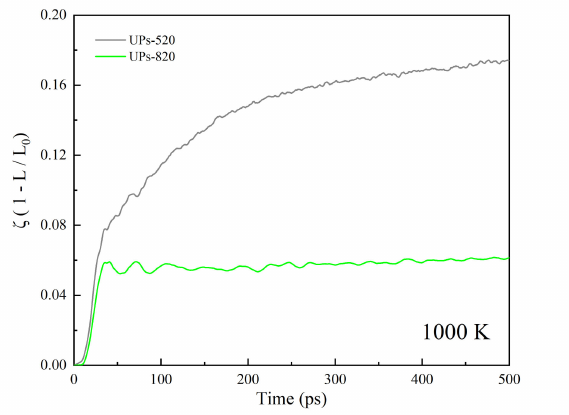
Figure 14. Shrinkage ( ζ ) of different UPs sintered at 1000 K corresponding to the sintering